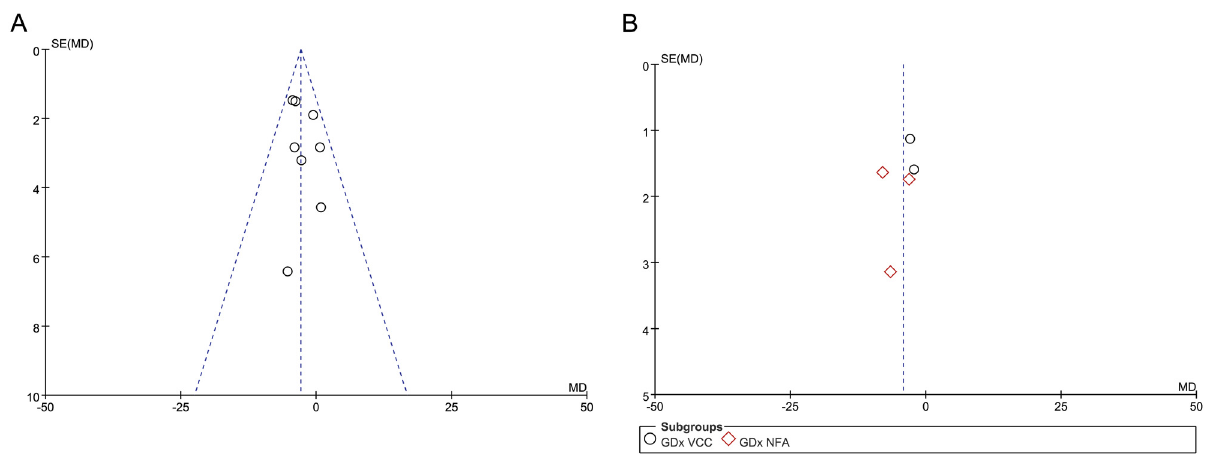
Fig 6. Funnel plot of all selected studies using OCT and studies using SLP. A, Funnel plot of studies using OCT; B, Funnel plot of studies using SLP.